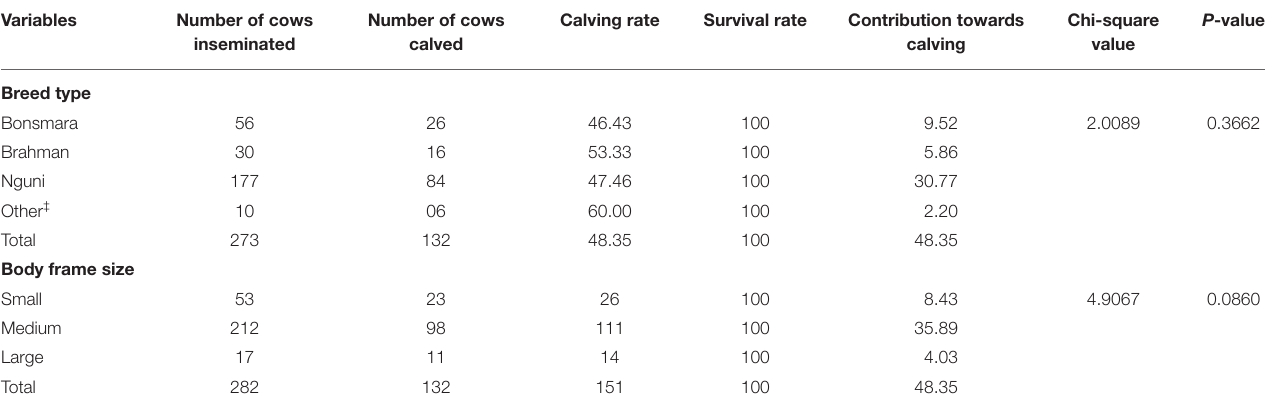
TABLE 6 | Effect of breed and body frame size on calving and survival rate of cows under communal and emerging farming systems.